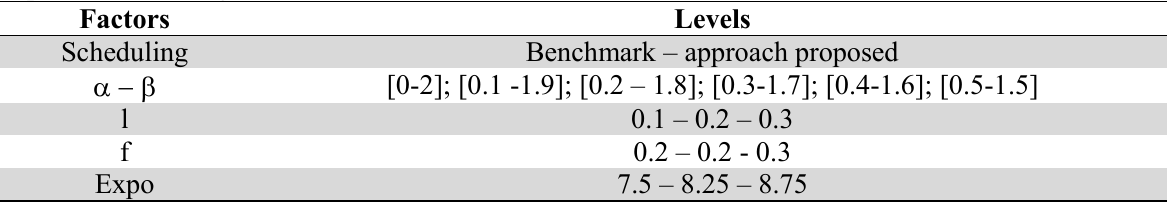
Experimental setting Factors Levels Scheduling Benchmark – approach